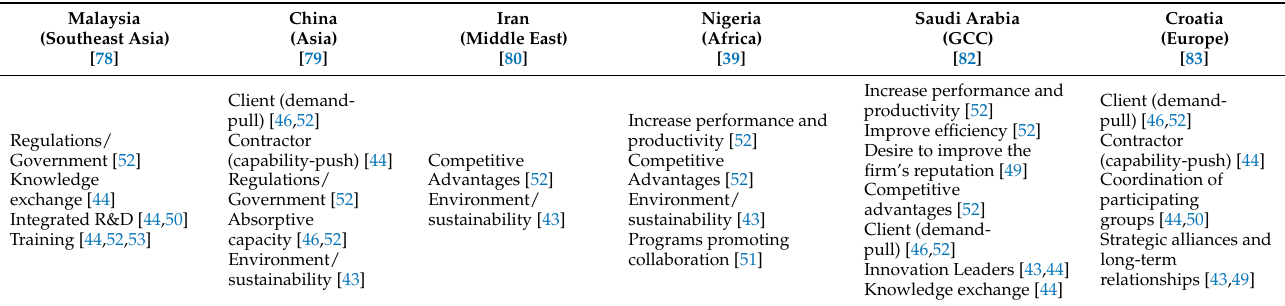
Table 5. Drivers of BIM innovation in developing